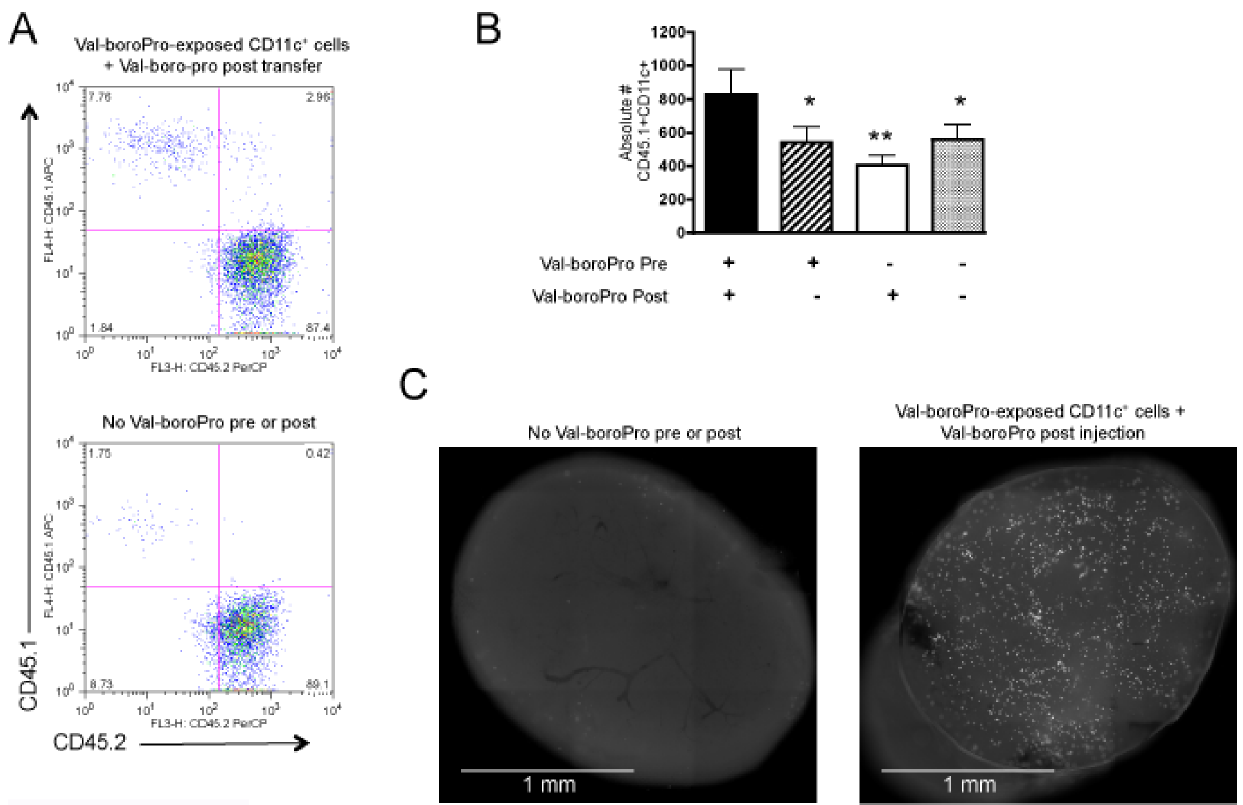
Figure 8. Antitumor activity with Val-boroPro is associated with increased trafficking of DCs. (A–B) B6CD45.1 congenic mice were treated with 20 m g Val-boroPro for three days, and CD11c + cells from spleens and LNs were magnetic bead purified and injected at a dose of 5 6 10 6 into lateral tarsals of C57BL/6 (CD45.2 + ) recipients. Immediately following CD11c + cell injection, recipients were treated with Val-boroPro or saline (n=3/group). Popliteal lymph nodes were harvested 15 hours following Val-boroPro treatment for flow cytometric analysis. (A) Representative dot plots. (B) Bar graph showing statistically more CD45.1 + adoptive transferred DCs in the popliteal LN in recipients of DCs from Val-boroPro treated donors also receiving a single injection of Val-boroPro compared to all other group (*p , 0.05, **p , 0.01, Mann-Whitney). (C) Purified CD11c + cells from Val-boroPro treated GFP + mice were injected intratumorally into established MB49 tumors. Mice were treated immediately thereafter with one dose of Val-boroPro (n=3/group). Tumor-draining inguinal lymph nodes were harvested 15 hours later and imaged by fluorescent microscopy. Representative lymph nodes from mice receiving CD11c + cells from Val-boroPro treated donors and Val-boroPro post injection. Experiments displayed in Figures 8A–C were conducted 2 times.